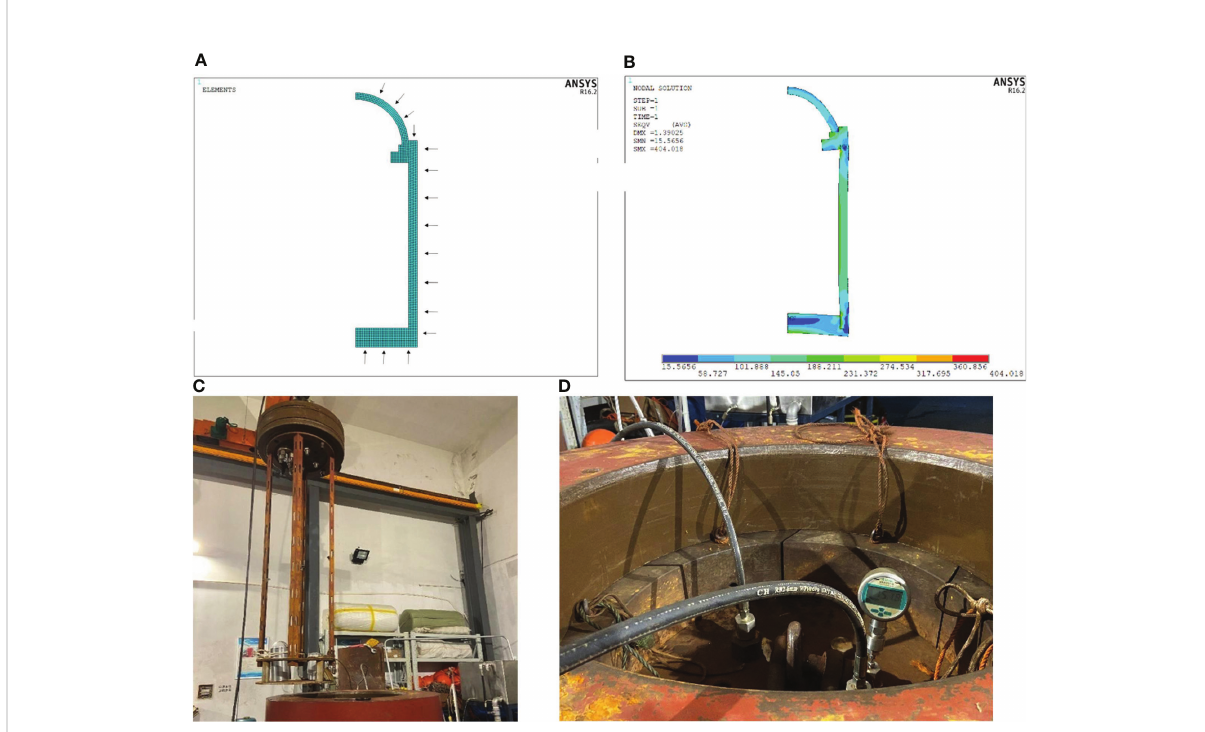
FIGURE 11 The pressure withstand experiment: (A) load model, (B) stress diagram of housing, (C) test in high-pressure experimental chamber, (D) pressure